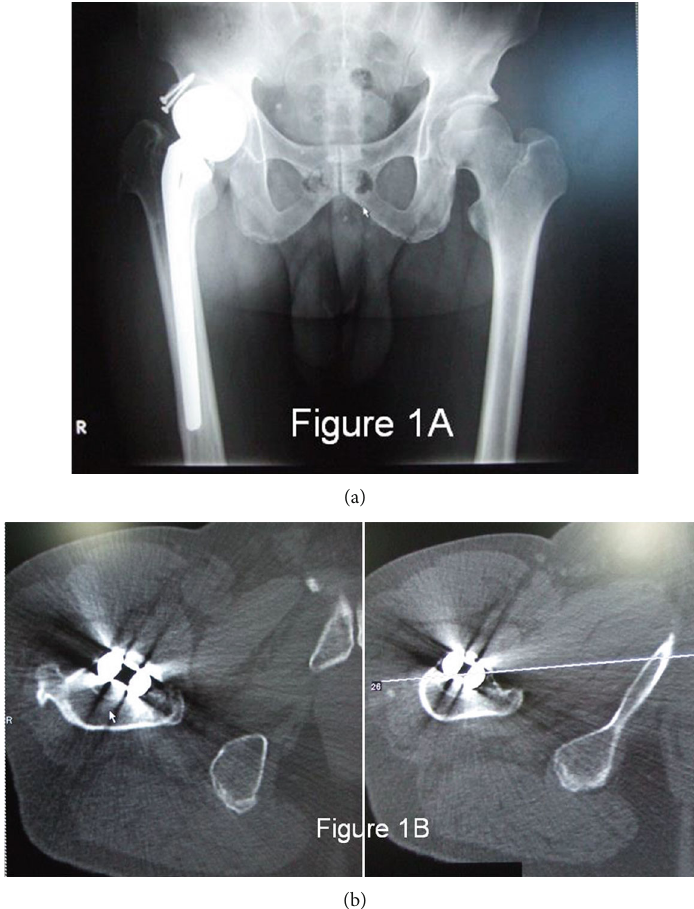
Figure 1: (a) Plain X-P shows the femoral prosthesis subsidence and slight internal migration of bipolar head. (b) Preoperative CT shows the retroverted femoral prosthesis and calcar bone